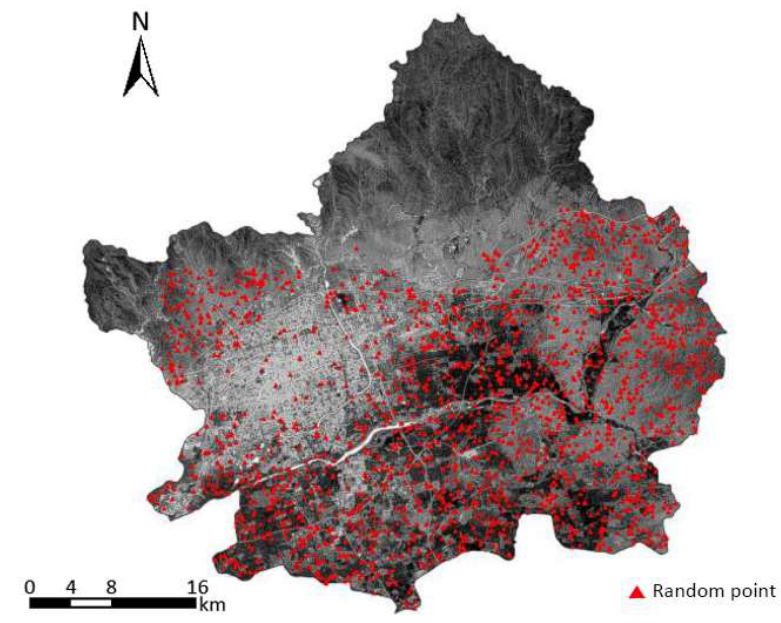
Figure 7. A diagram of the spatial distribution of sampling points.